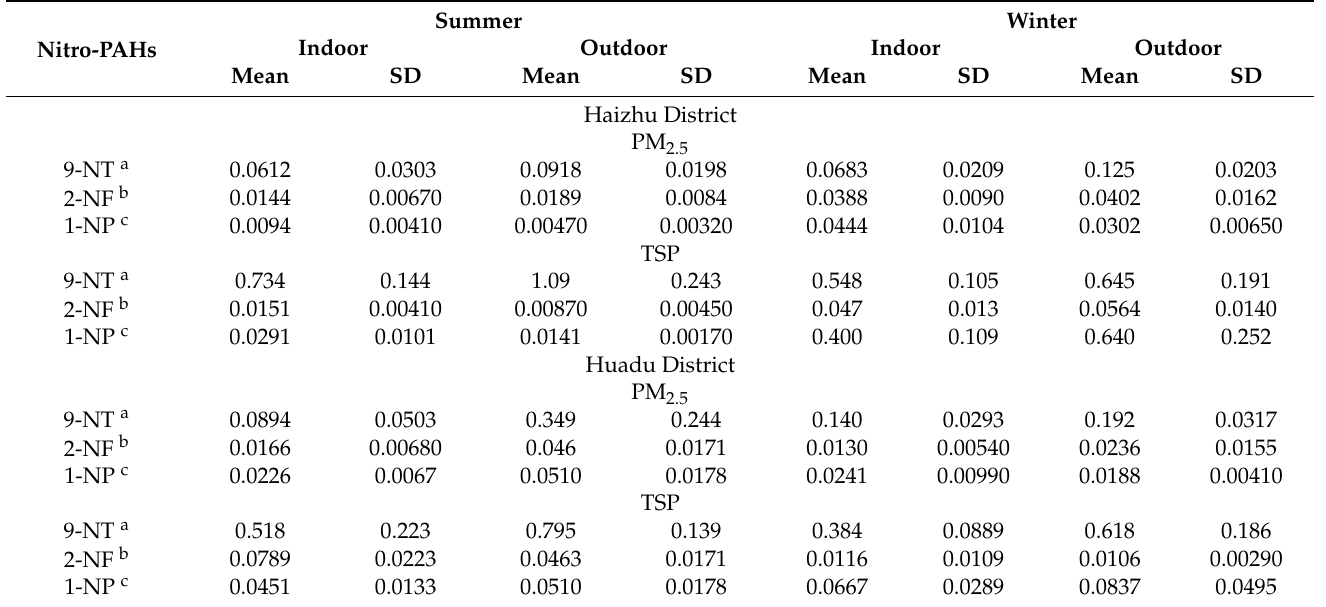
Table 1. Mean nitro-PAH concentrations (ng/m 3 ) and standard deviations of 9-NT, 2-NF, and 1-NP in PM 2.5 and TSP in 2019.